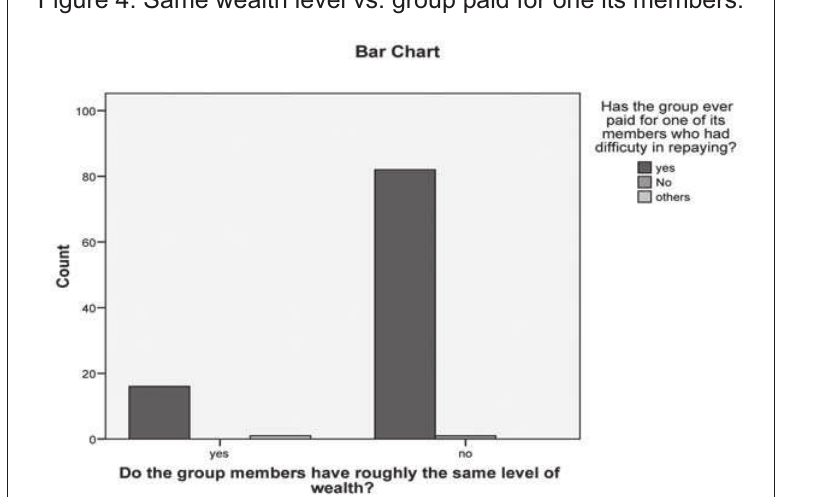
Figure 4. Same wealth level vs. group paid for one its members.